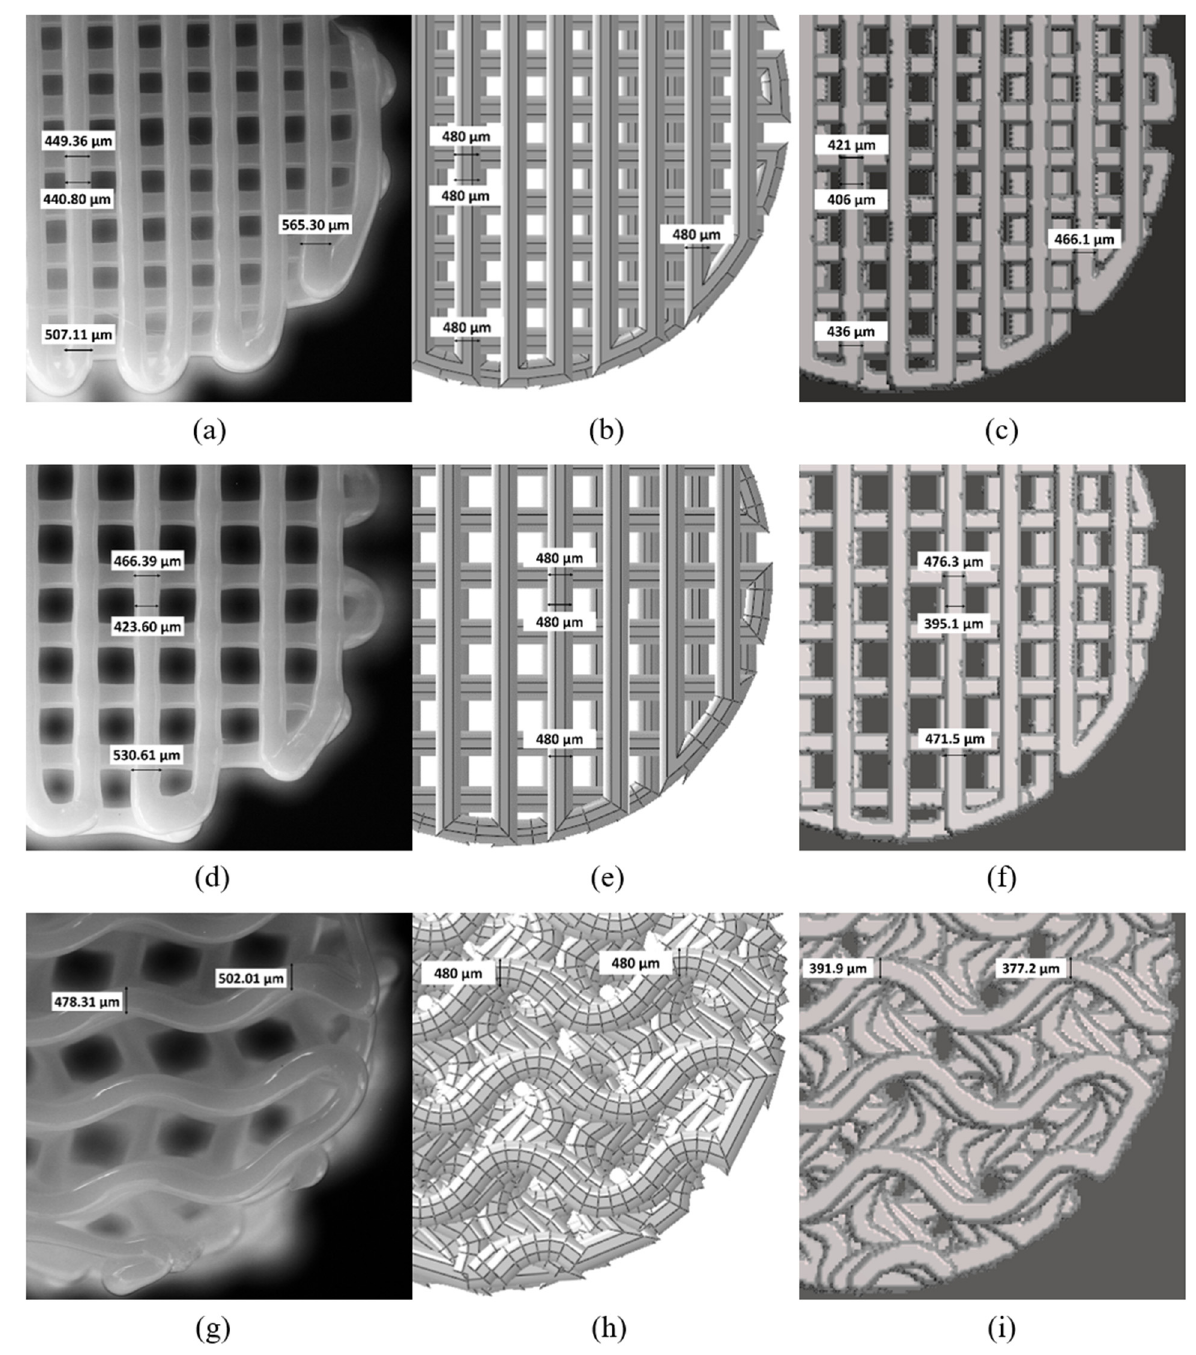
Figure 13. Filament width comparison of: ( a ) 50_rect microscopy image of printed scaffold, ( b ) 50_rect CAD model, ( c ) 50_rect voxelised model, ( d ) 60_rect microscopy image of printed scaffold, ( e ) 60_rect CAD model, ( f ) 60_rect voxelised model, ( g ) 50_gyr microscopy image of printed scaffold, ( h ) 50_gyr CAD model and ( i ) 50_gyr voxelised model.